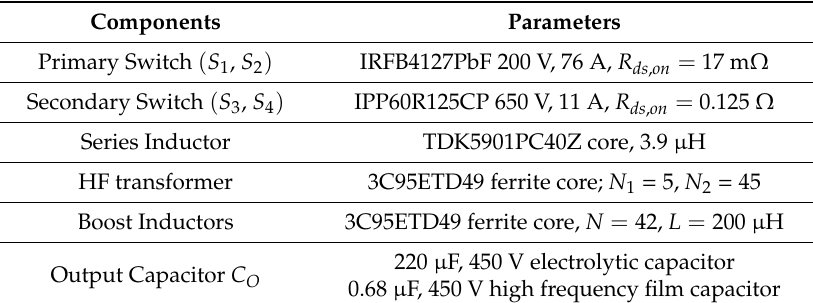
Figure 15. Laboratory prototype of the half-bridge converter. Table 2. Component parameters of the hardware prototype.